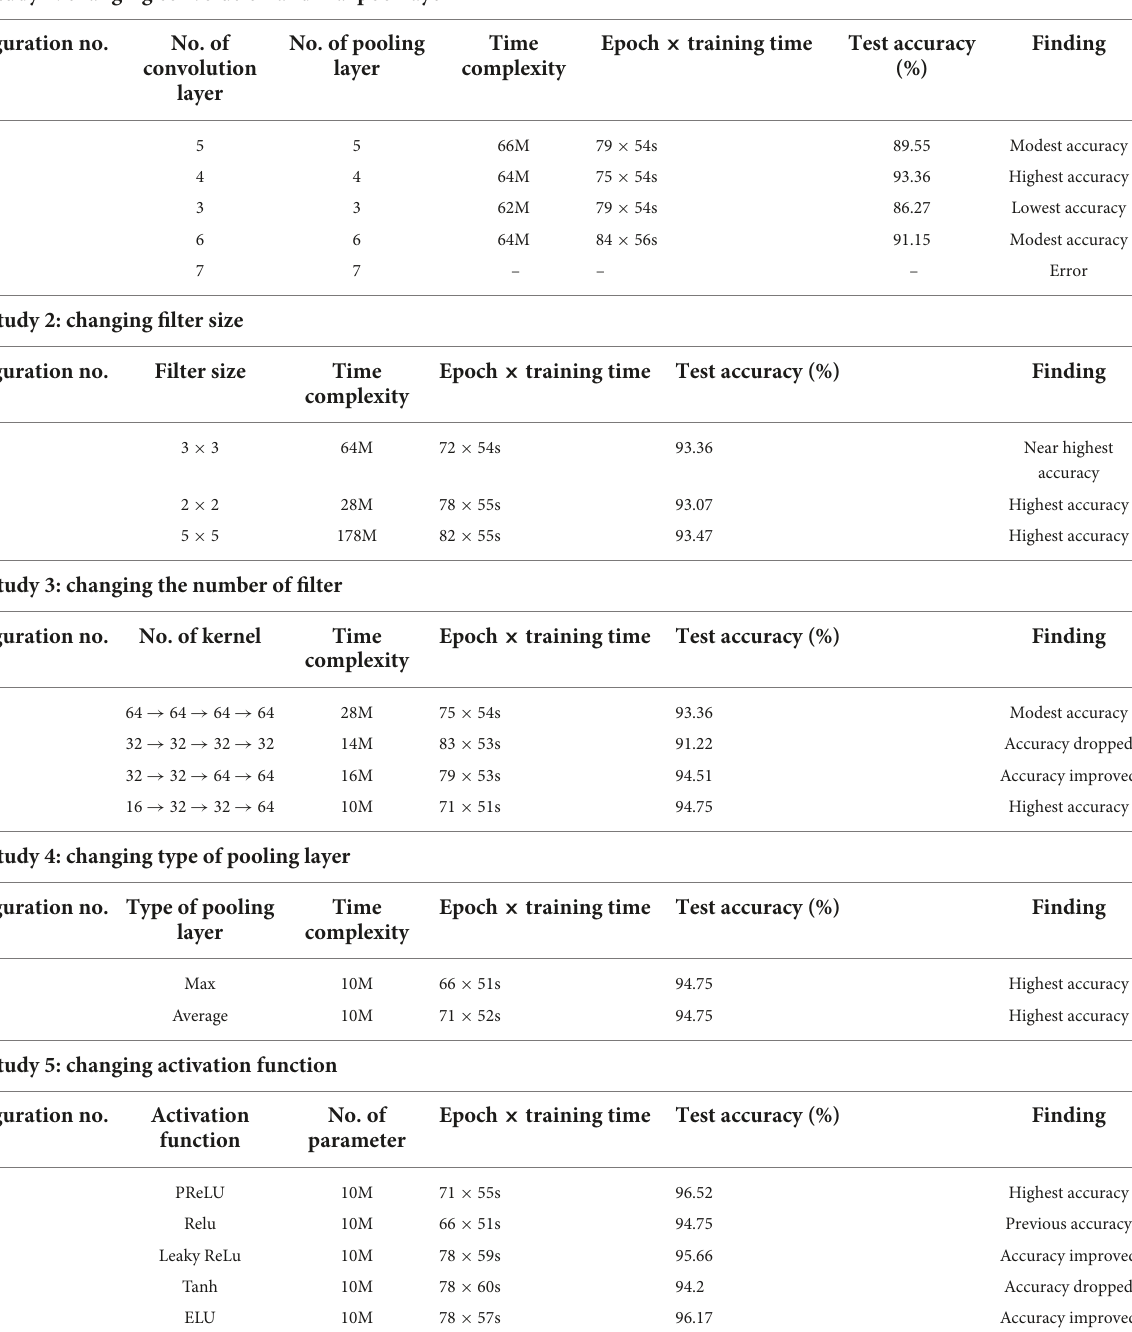
TABLE 3 Ablation study on layer configurations and activation